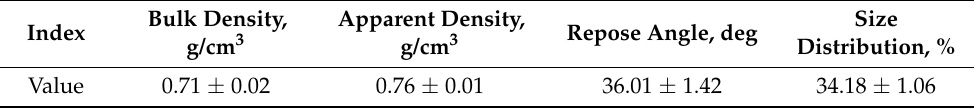
Table 2. The main physical parameters of the mash.